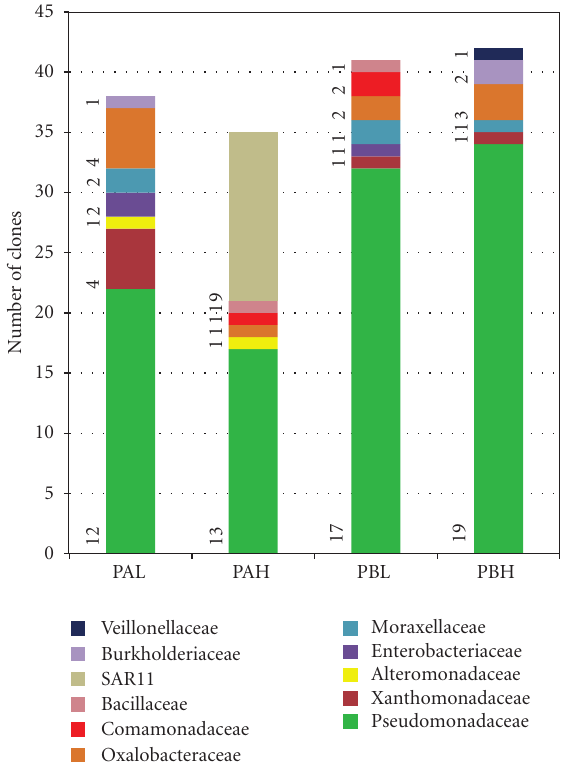
Figure 1: Frequency of clones a ffi liated with di ff erent bacterial families found in each oil sample from platforms A and B with low- (L) and high- (H) water contents. A total of 156 16S rRNA gene clones were classified by the RDP Classifier tool. The number of OTUs corresponding to each family is indicated close to the graph bar. OTUs were defined using a distance level of 3% by using the furthest neighbor algorithm in MOTHUR. PAL—crude oil from Platform A with low-water content (5%); PAH—crude oil from Platform A with high-water content (60%); PBL—crude oil from Platform B with low water content (1%); PBH—crude oil from Platform B with high water content